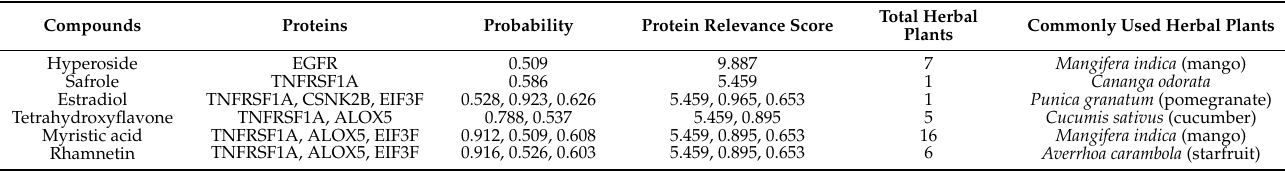
Table 5. Ten compound–protein interactions with the highest protein relevance score of SAE-DNN prediction results with daylight fingerprint dataset.